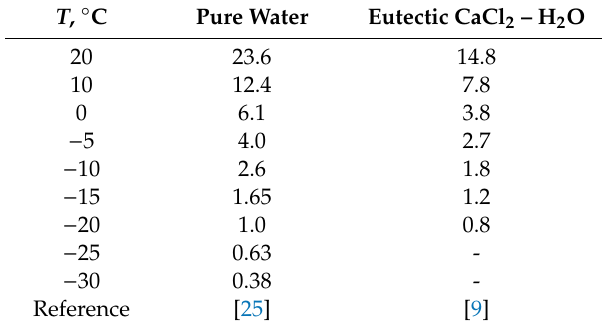
Table 3. Vapour pressure (in mbar) over pure water / ice and eutectic (CaCl 2 – H 2 O) solution at a low